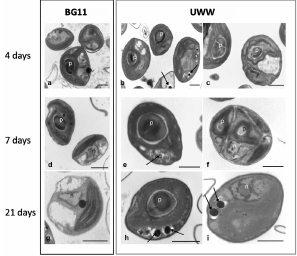
Figure 6. Transmission electron micrographs of microalgae cultivated in modified BG11 and UWW at 4, 7 and 21 days of cultivation. ( a , d , g ) Cells grown in BG11 synthetic medium and ( b , c , e , f , h , i ) in UWW e ffl uent for 4 ( a – c ), 7 ( d – f ) and 21 ( g – i ) days. In ( c ) and in ( f ), a dividing cell and a sporocyst are visible, respectively. p, pyrenoid; n, nucleus; arrows, dark polyphosphate precipitates. Bars, 1 µ